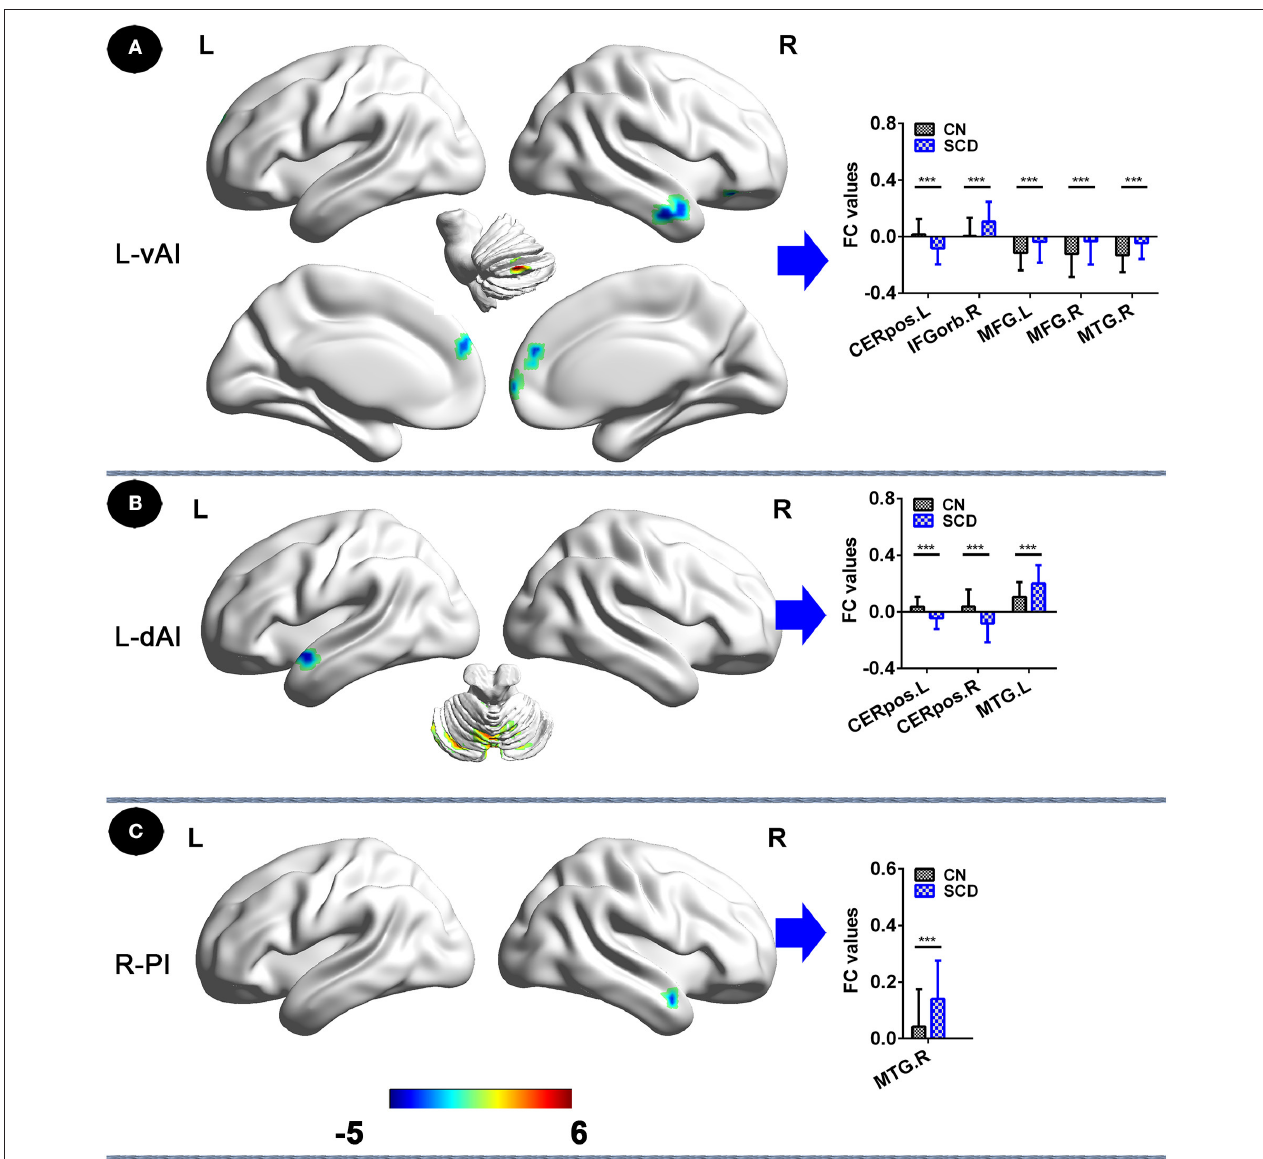
FIGURE 1 | Insular subnetwork functional connectivity in patients with SCD compared to CNs. (A) The different brain regions of the FC of the left vAI subregion between CN and SCD. A bar chart indicating the quantitative comparison of functional connectivity between these regions. (B) FC of left dAI subregion between CN and SCD. A bar chart indicating the quantitative comparison of FC between these regions. (C) FC of the right PI subregion between CN and SCD. A bar chart indicating the quantitative comparison of FC between these regions. * P TFCE − FWE < 0.05. Note: only subnetworks that show significant differences in between-group comparisons are shown here. All results are displayed after adjusting for age, sex, education, ITV, and FD. A threshold of p < 0.05 was applied, and TFCE-FWE correction with cluster size > 270 mm 3 . FC, functional connectivity; CN, normal control; SCD, subjective cognitive decline; L-vAI, left ventral anterior insula; L-dAI, left dorsal anterior insula; R-PI, right posterior insula; TFCE, threshold-free cluster enhancement; FEW, family-wise error; ITV, intracranial volume; FD, frame-wise displacement; CERpos.L, left cerebellum posterior lobe; CERpos.R, right cerebellum posterior lobe; MTG.R, right middle temporal gyrus; IFGorb.R, right inferior frontal gyrus, orbital part; MFG.R, right medial frontal gyrus; MFG.L, left medial frontal gyrus; MTG.L, left middle temporal gyrus.